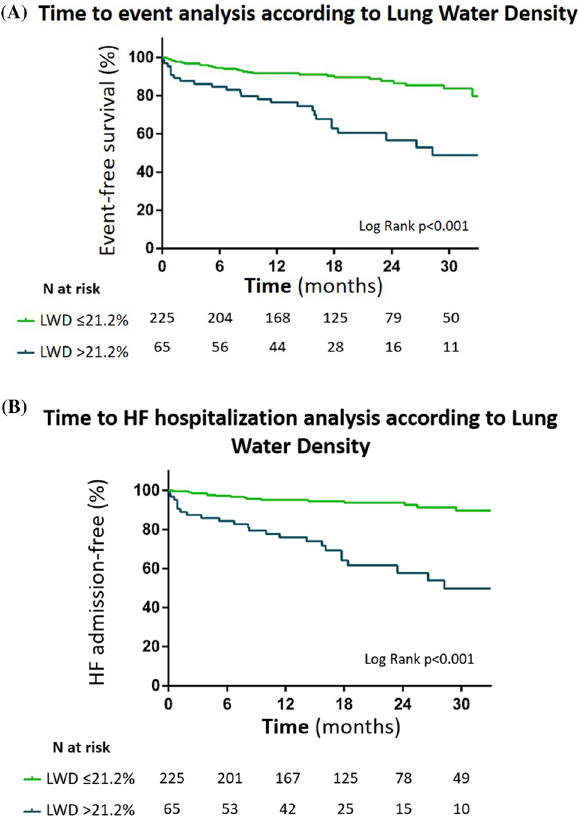
Figure 2. ( A ) Kaplan–Meier curves for 290 HF patients and LVEF < 50% with increased (> 21.2%) or normal LWD (≤ 21.2%) for the primary composite endpoint (i.e., all-cause death or HF hospitalization) presented as event-free survival (%) at 30 months. Compared to normal LWD, those with increased LWD were significantly more likely to have an event (log rank p < 0.001). LWD lung water density. ( B ) Kaplan–Meier curves for 290 HF patients and LVEF < 50% with increased (> 21.2%) or normal LWD (≤ 21.2%) for HF hospitalization presented right-censored at 30 months. Compared to normal LWD, patients with increased LWD were significantly more likely to have at least one HF hospitalization (log rank p < 0.001). LWD lung water